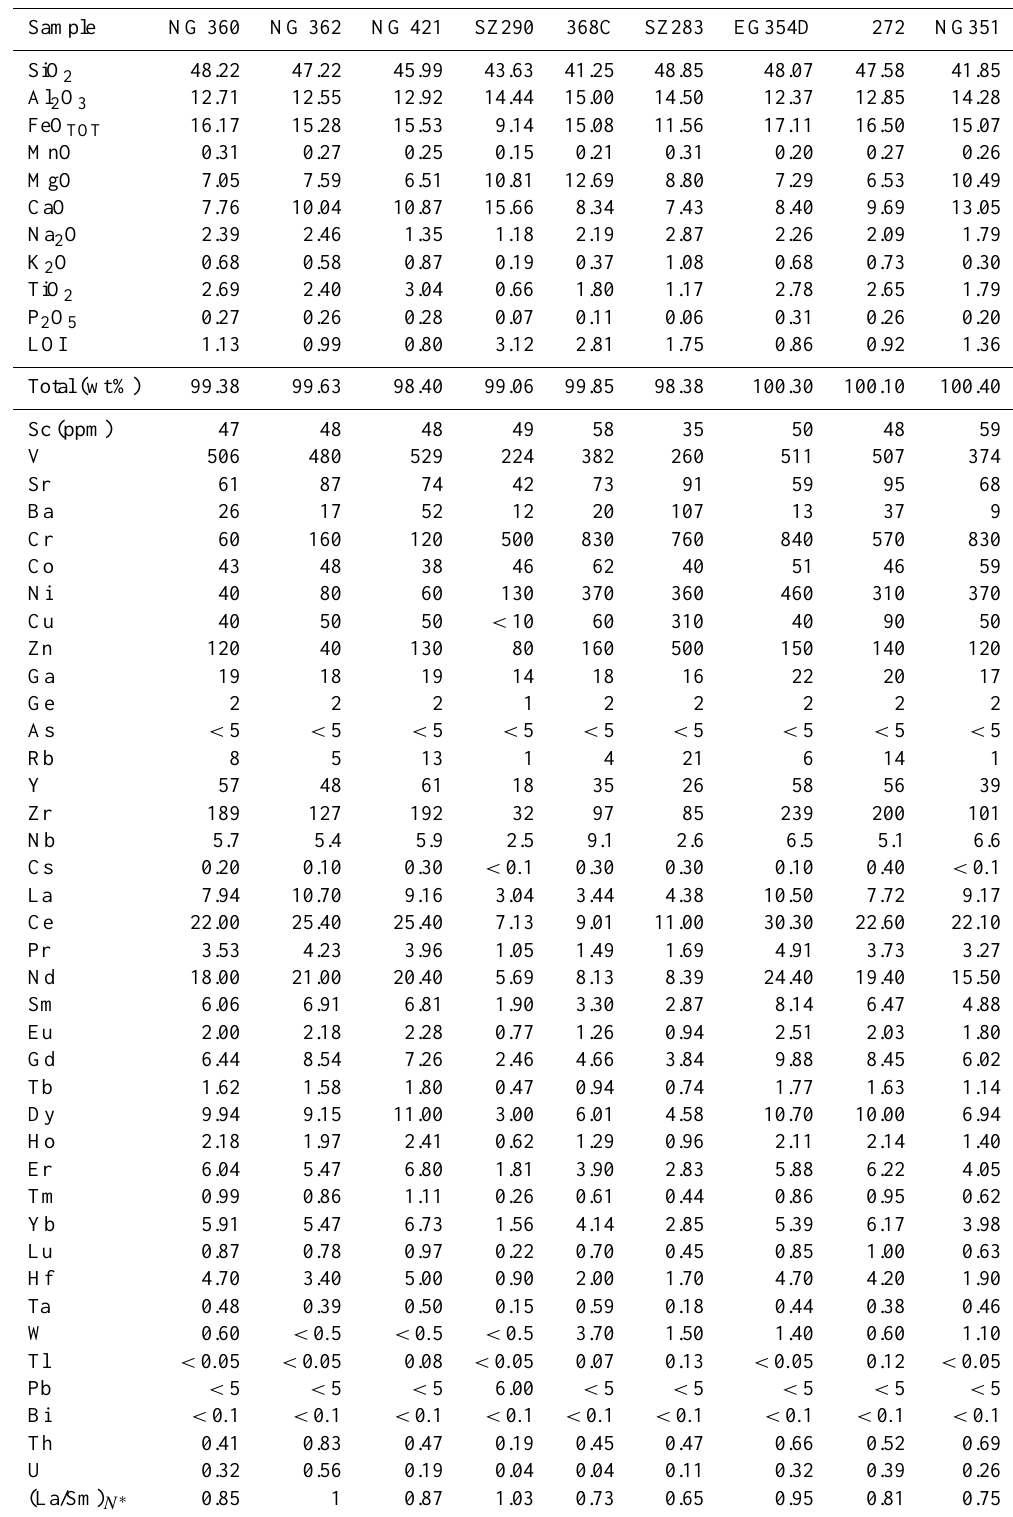
Table 3. Major and trace element composition of the Sabzevar granulite samples.